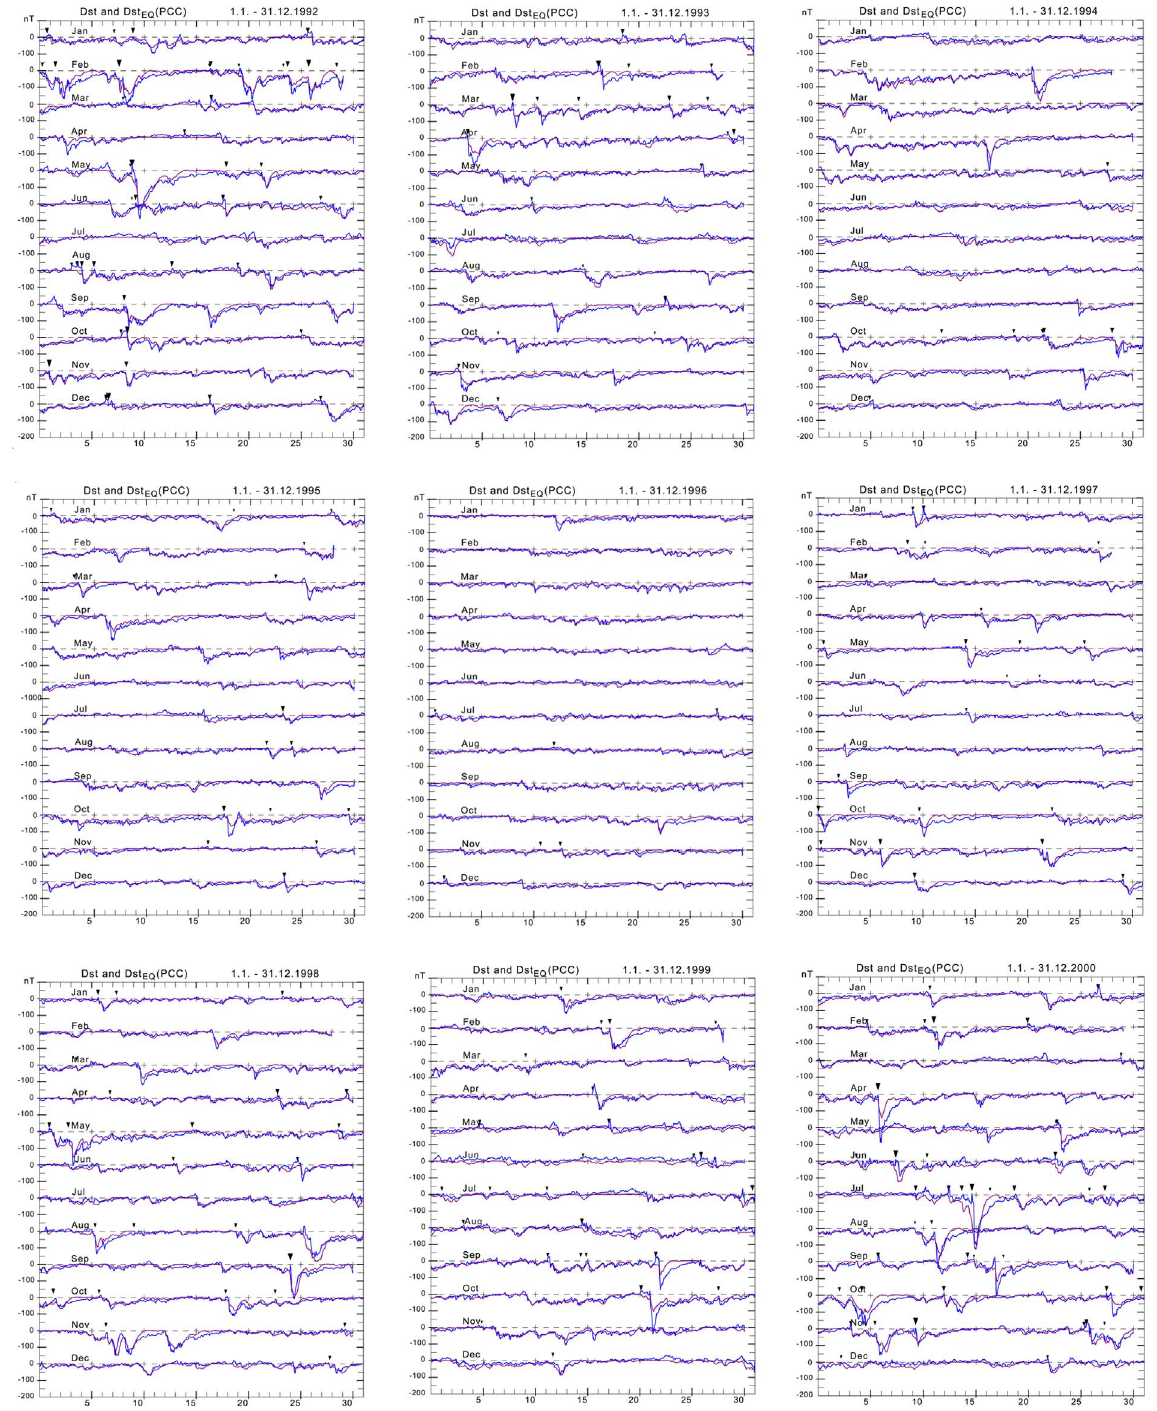
Fig. A1. Dst and Dst EQ 1992 – 2000. Dst (blue line), Dst EQ (magenta